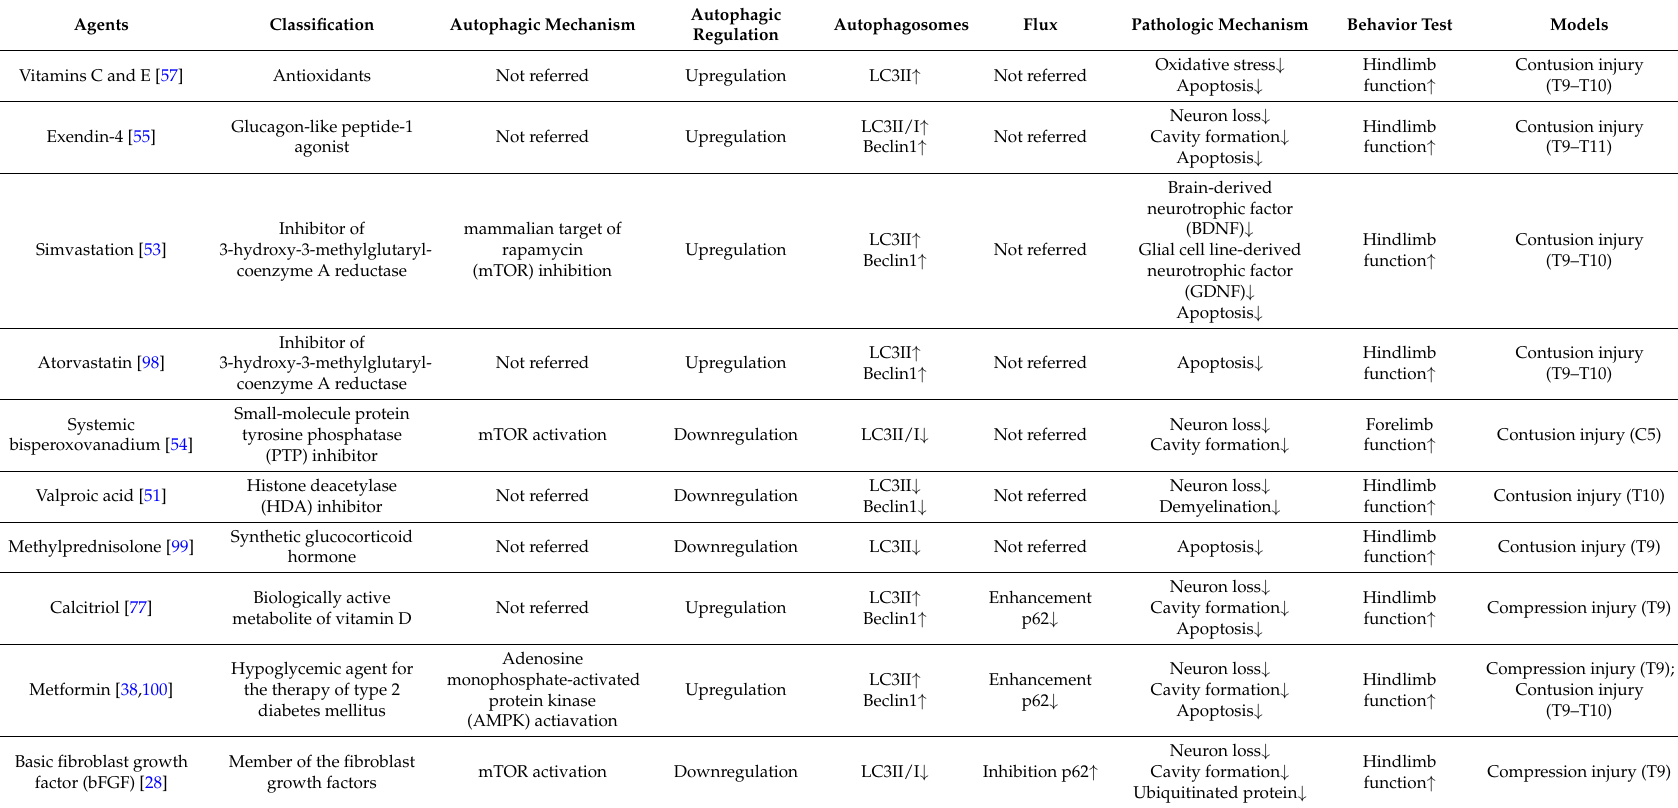
Table 1. Therapeutic agents regulate the level of autophagy in experimental